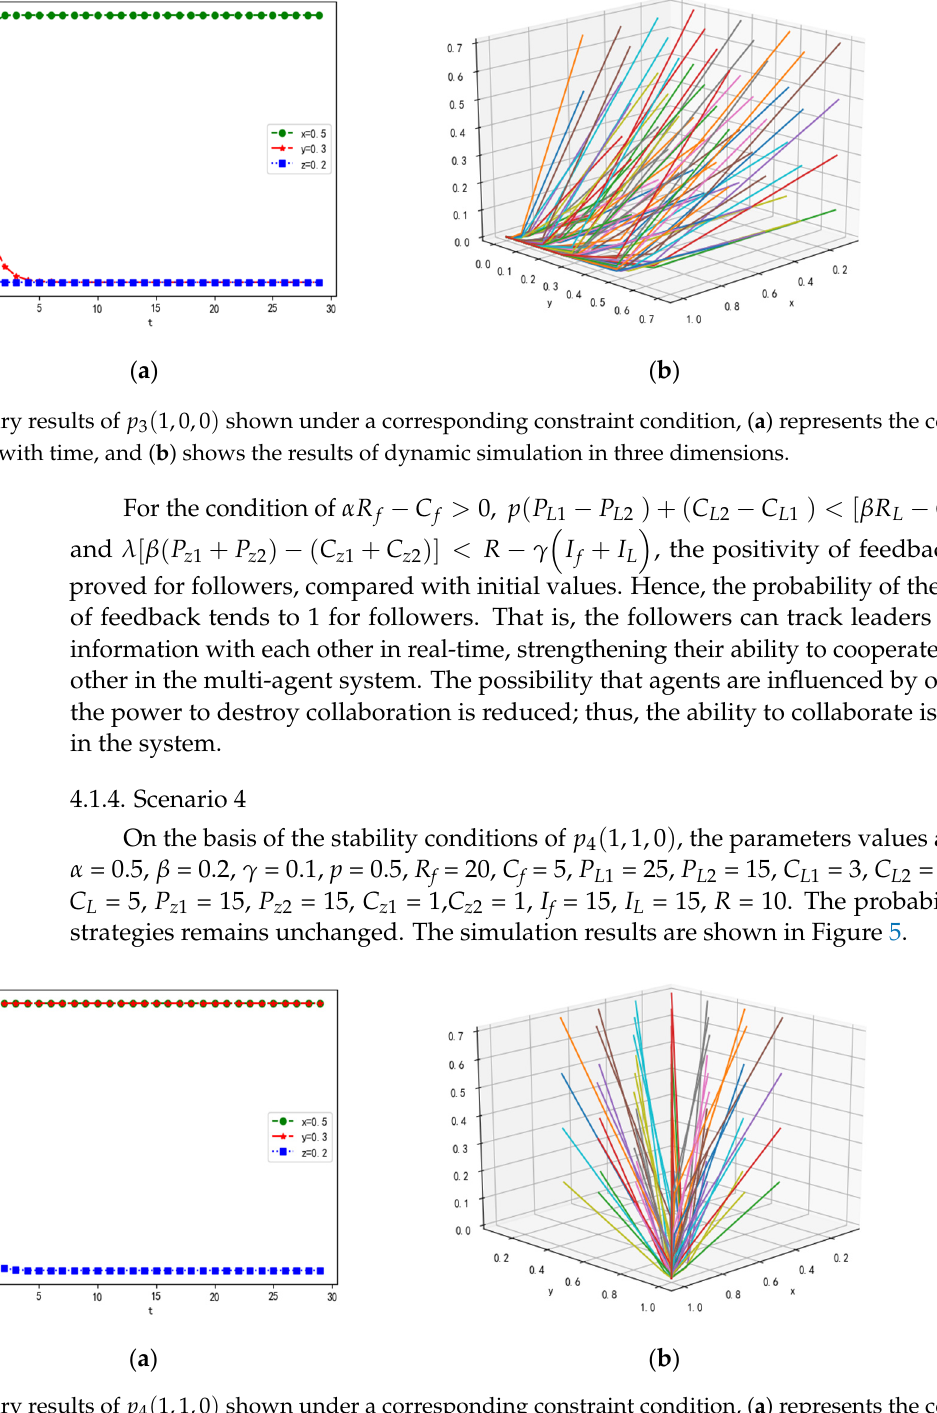
Figure 5. Evolutionary results of p 4 ( 1,1,0 ) shown under a corresponding constraint condition, ( a ) represents the conver- gence of probability with time, and ( b ) shows the results of dynamic simulation in three dimensions.